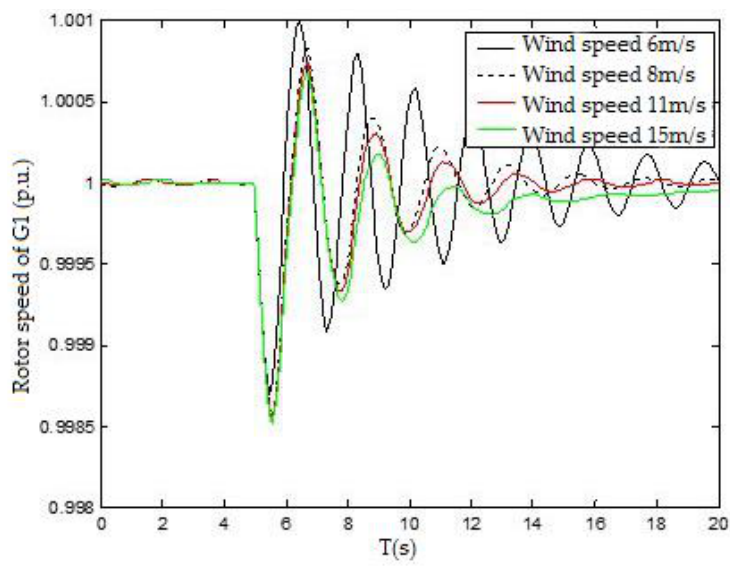
Figure 6. Dynamic response of rotor speed of G1 under different wind speed in supplementary damping control.